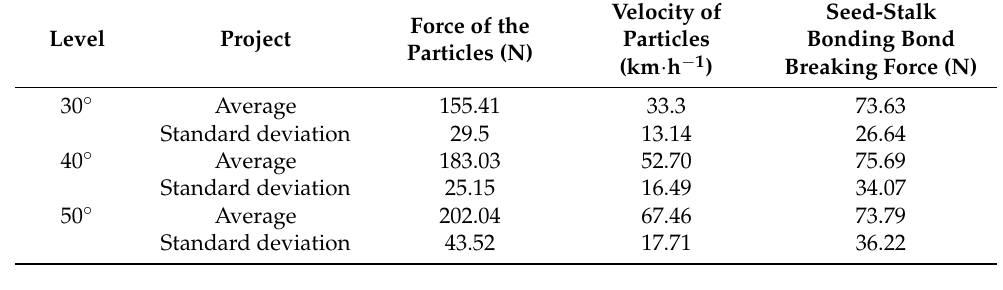
Table 6. Simulation results in different guide plate angle.